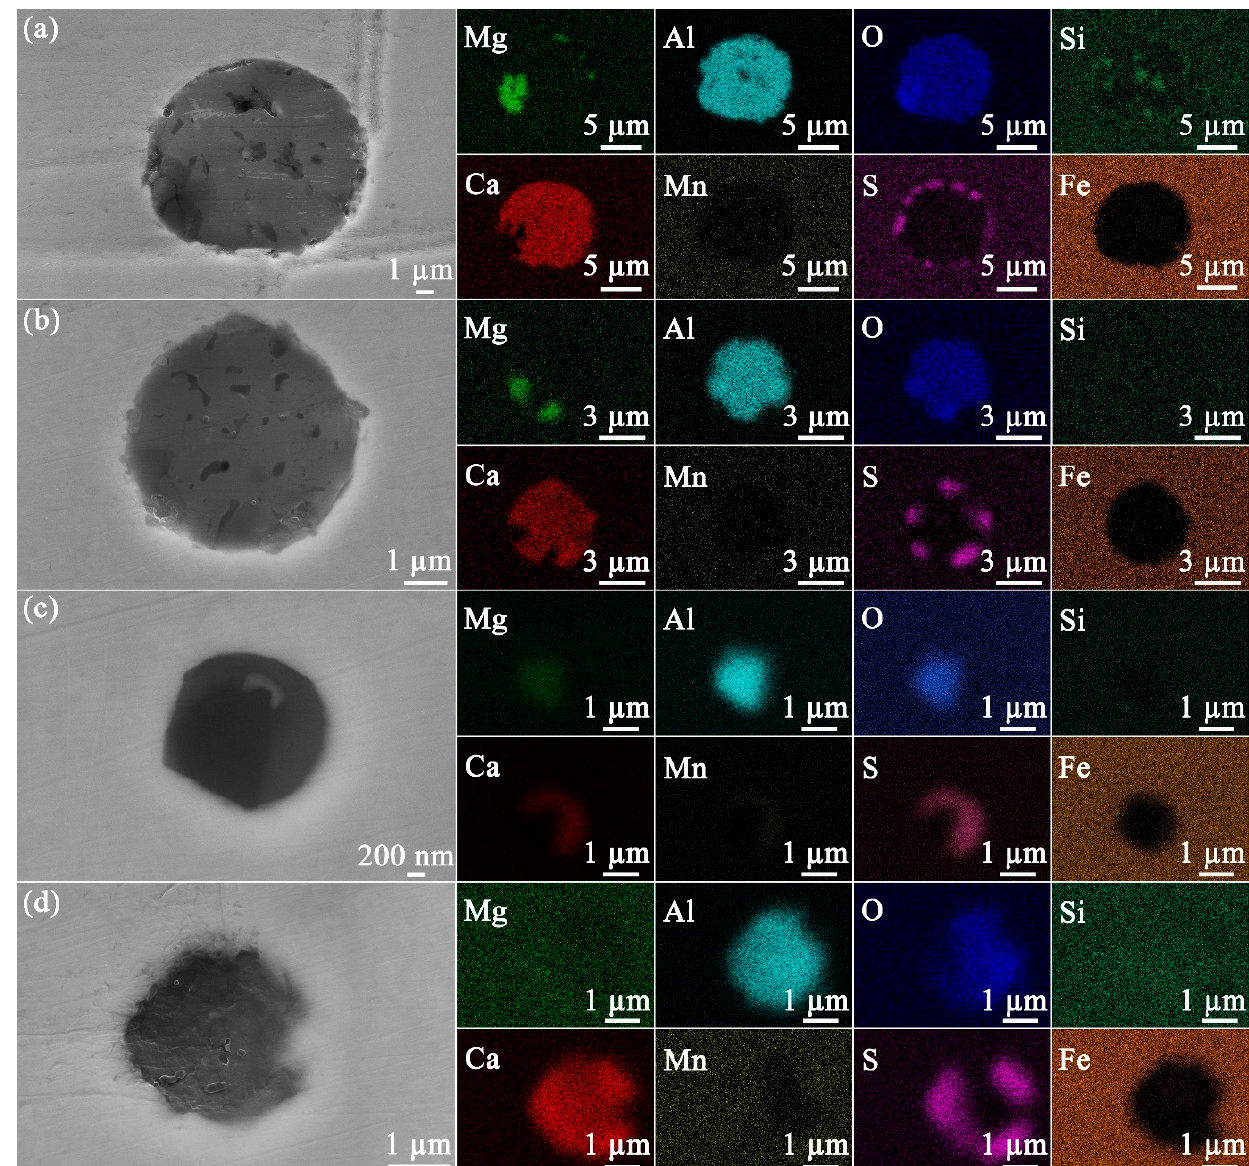
Figure 2. SEM/SE (secondary electron) images of inclusions containing ( a ) Mg − Al − Si − O − Ca − S, ( b ) Mg − Al − O − Ca − S, ( c ) Mg − Al − O − Ca − Mn − S, and ( d ) Al − O − Ca − S on unexposed steel. The elemental distributions of the inclusions are given at right.